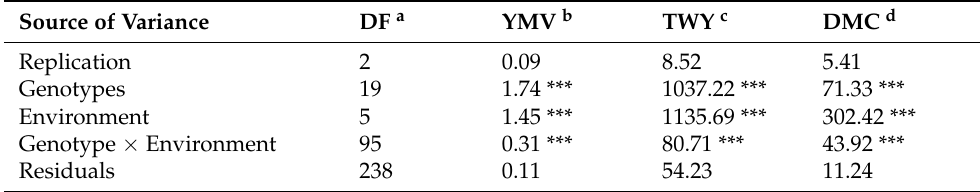
Table 2, c annual minimum temperature, d annual maximum temperature. Table 5. Analysis of variance for performance of 20 yam genotypes evaluated in six test environments within Uganda with respect to yam mosaic virus, tuber yield and dry matter